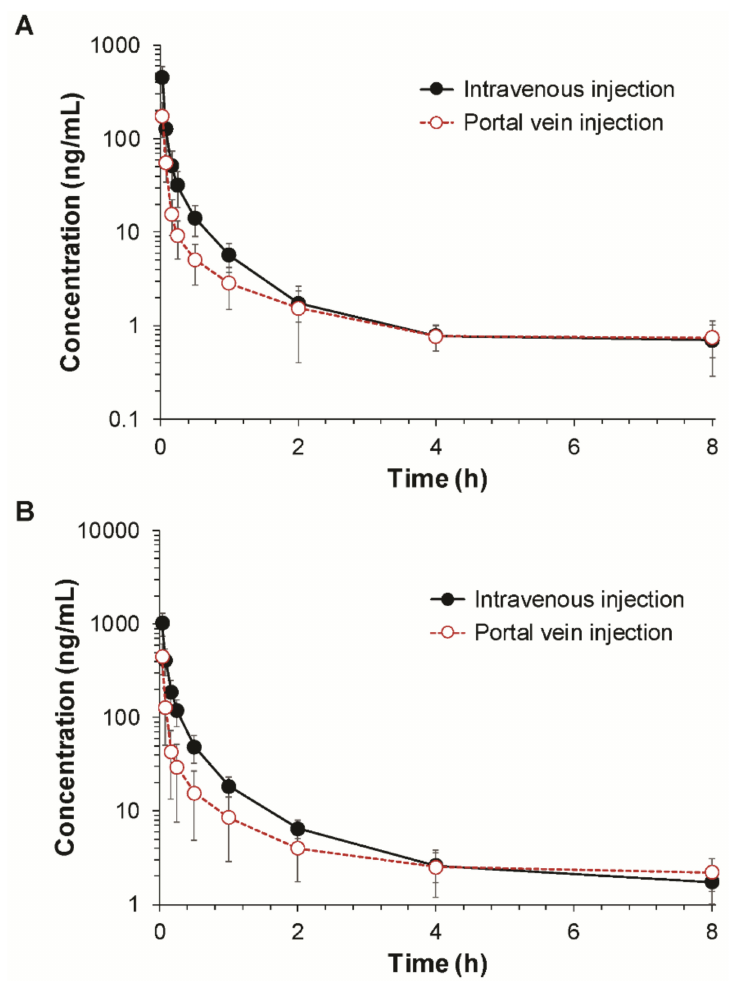
Figure 2. Plasma concentration–time profiles of fimasartan following the intravenous and portal venous injections of fimasartan at doses of ( A ) 0.1 mg/kg ( n = 8–9) and ( B ) 0.3 mg/kg ( n = 5–8) in rats (mean ± SD). 3.2. The Gastrointestinal Permeability of Fimasartan Determined by Using the Single-Pass Perfusion The regional absorptions of fimasartan in the duodenum, small intestine, and large intestine were evaluated by in situ single-pass intestinal perfusion. The absorption clearance ( P e A ) and the fraction absorbed ( F abs ) of fimasartan through the duodenum, small intestine, or large intestine after initiation of the perfusion are shown in Figure 3. The outflow drug concentration reached the steady state within 1 h after the initiation of the perfusion. The steady-state P e A and F abs were calculated based on C in and C out at 90 min. The steady-state P e A and F abs values of fimasartan in the different gastrointestinal regions determined by the in situ single-pass perfusion method are shown in Table